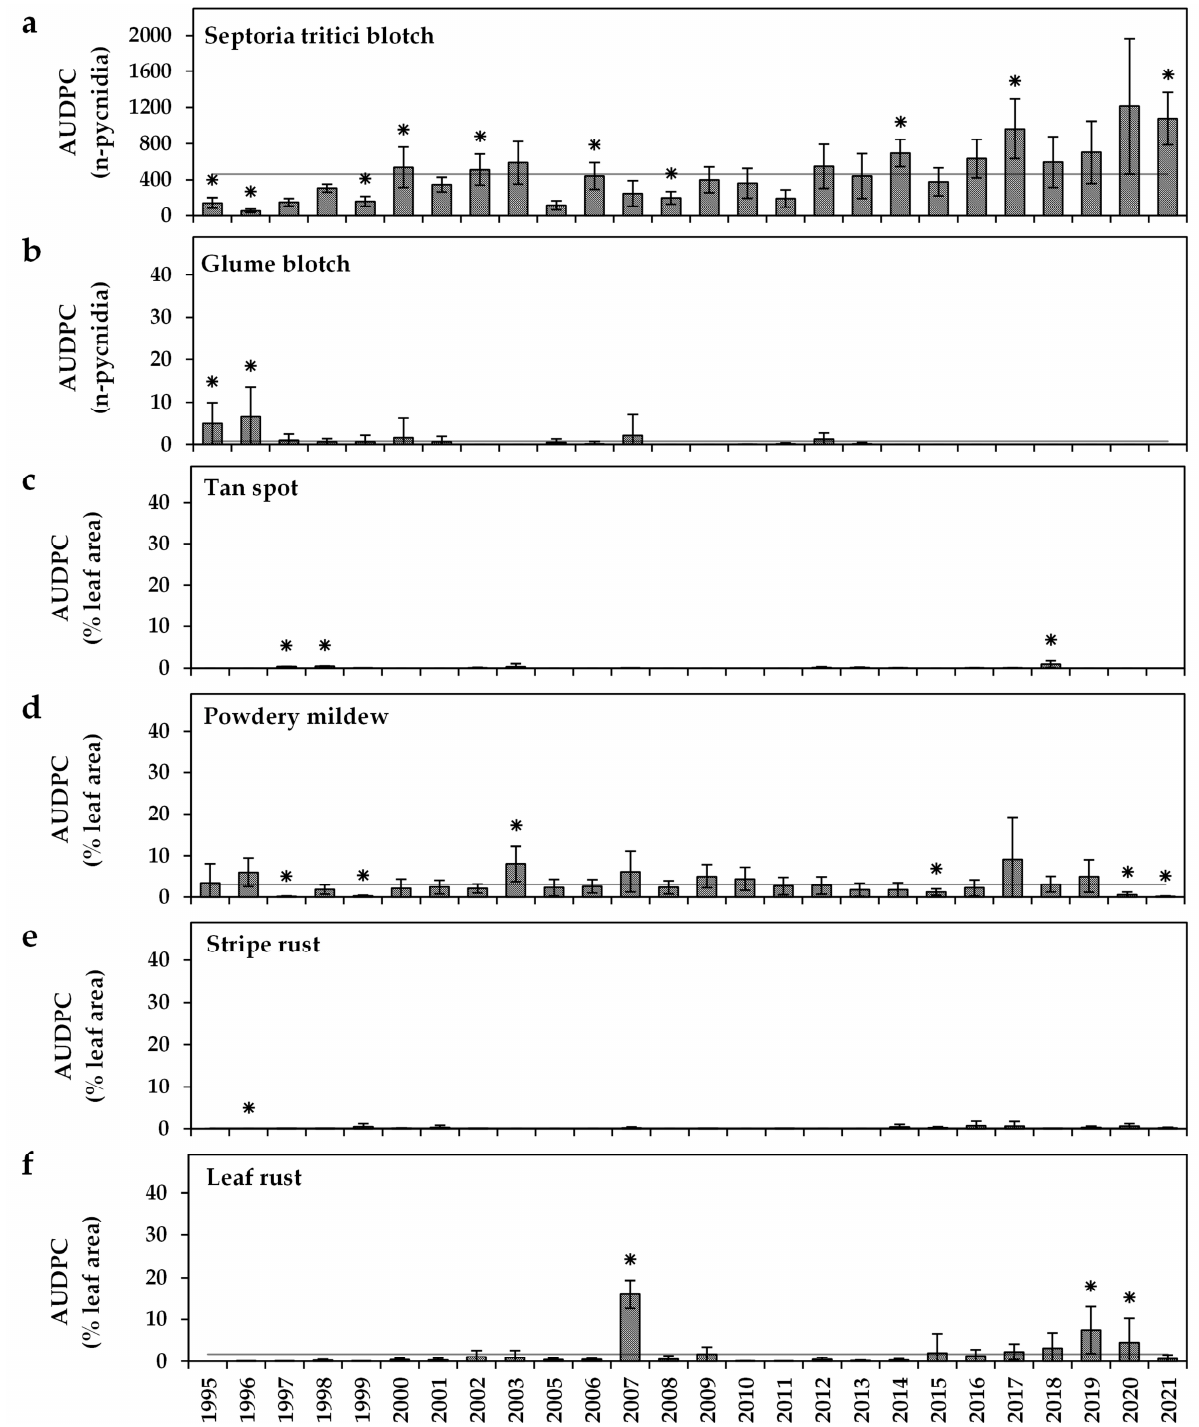
Figure 1. Average of disease severities from 1995 to 2021 (grey line) and annual disease severities (AUDPC; GS 30 to 77; bars) of ( a ) Septoria tritici blotch (number of pycnidia), ( b ) glume blotch (number of pycnidia), ( c ) tan spot (percentage of leaf area affected), ( d ) powdery mildew (percentage of leaf area affected), ( e ) stripe rust (percentage of leaf area affected), and ( f ) leaf rust (percentage of leaf area affected) on the upper six leaves (F-0 to F-6) of winter wheat (cultivar “Ritmo”) in the untreated control of the eight trial locations in northern Germany from 1995 to 2021. Significant ( p ≤ 0.05) annual differences of disease severities from the average (grand mean) are marked with *.